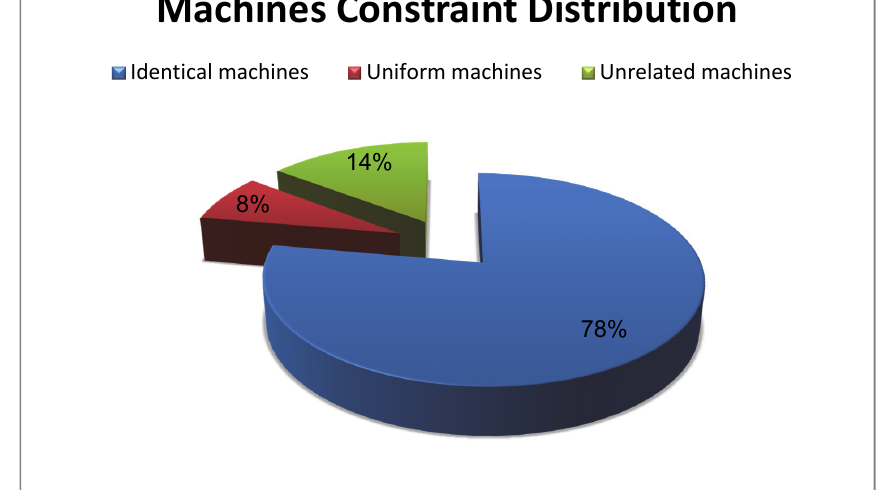
Fig. 1. Machines constraint